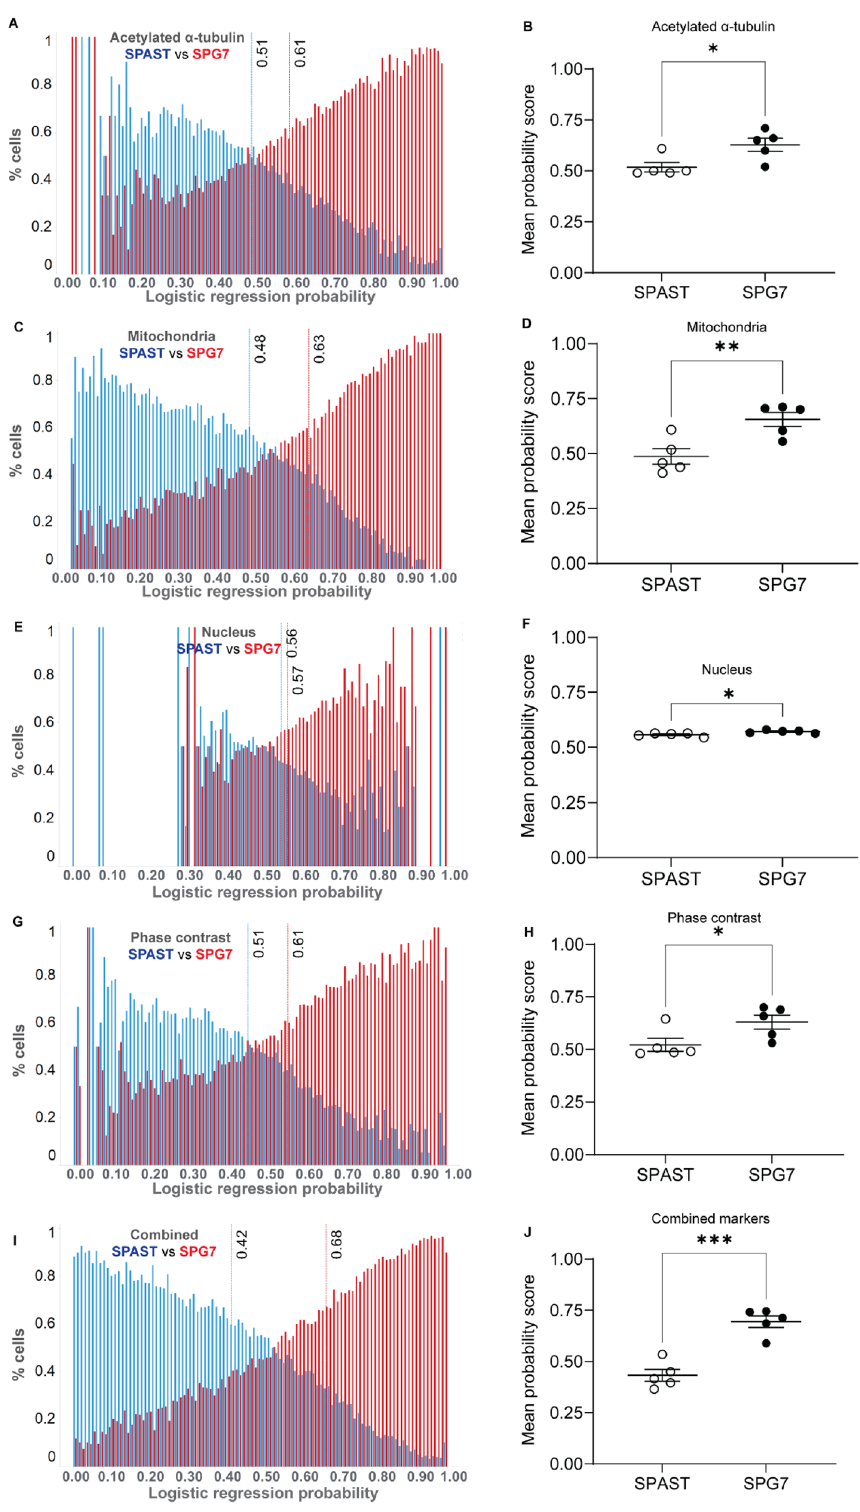
Figure 5. Logistic regression analysis of SPAST patient vs SPG7 patient samples. Histogram of single cell logistic regression probability scores is presented for 26,525 cells from 5 SPG7 patient and 5 control individuals for multiple cell components: acetylated α-tubulin ( A ), mitochondria ( C ), nucleus ( E ), cell phase contrast ( G ) and combined markers ( I ). Dotted lines indicate mean probability score values. The mean logistic regression probability score showing all the individual patient and control cell lines is presented for acetylated α-tubulin ( B ), mitochondria ( D ), nucleus ( F ), the cell (phase contrast image) ( H ) and combined markers ( J ). Mean values were compared using students